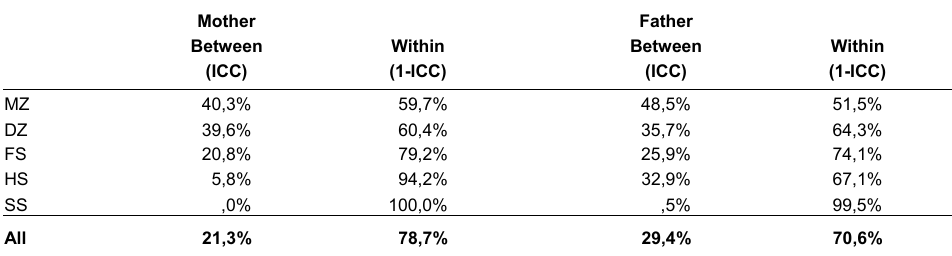
Table 4: Percent between- and within-family variance in random intercept models on children’s assessments of the relationships to their resident fathers and mothers, by type of sibship